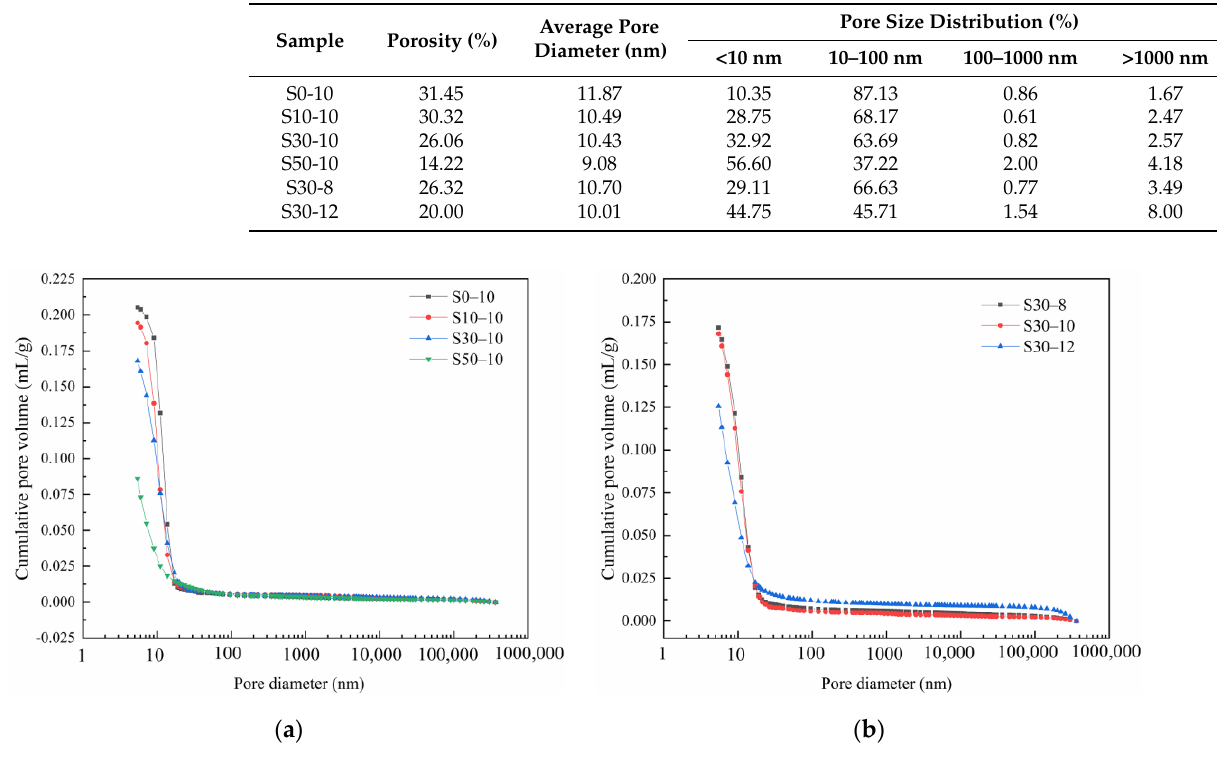
Figure 9. MIP spectra of the alkali-activated metakaolin-based geopolymer specimens according to the ( a ) slag and ( b ) Na 2 O content. Table 3. Pore size distribution of the metakaolin-based geopolymers.